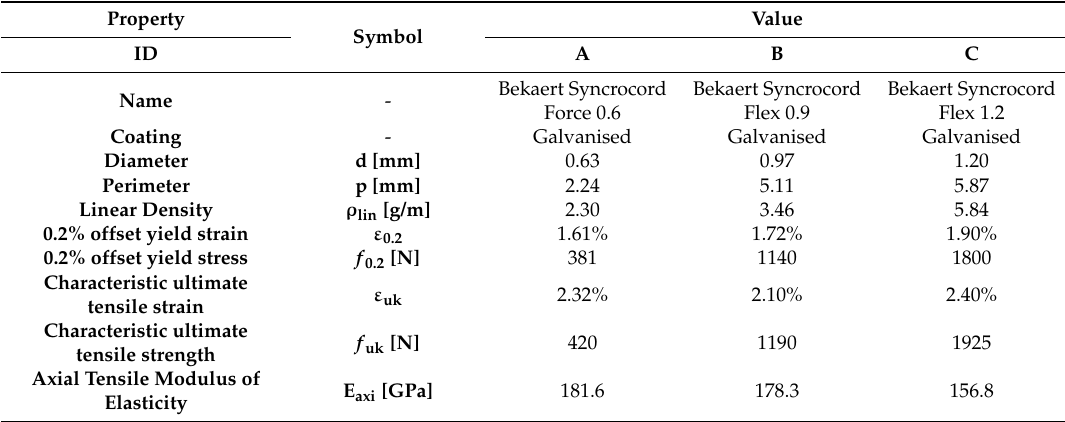
Table 1. Cables used as